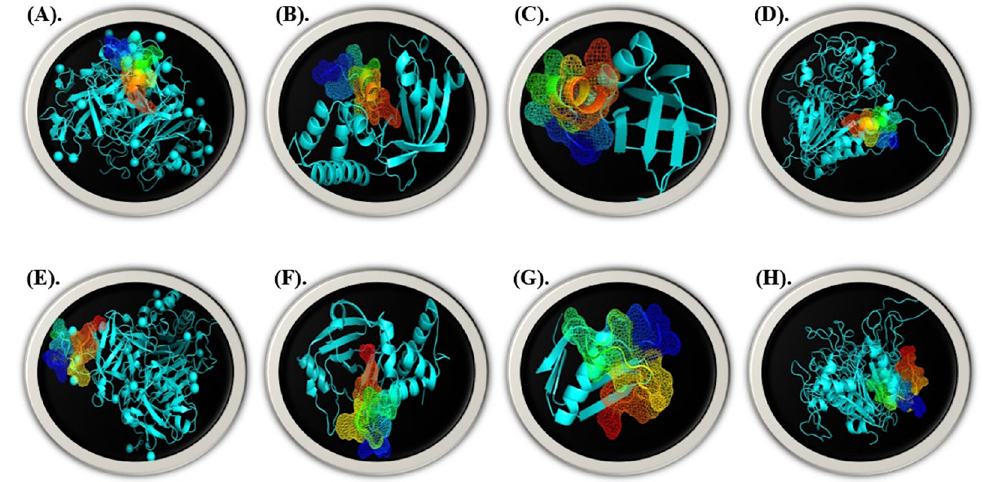
Figure 12. Visualized docked complexes by Pymol of streptin with ( A ). cdt, ( B ). spvB, ( C ). stxB, ( D ). ymt and of Ruminococcin-A with ( E ). cdt ( F ). spvB ( G ). stxB ( H ). ymt.